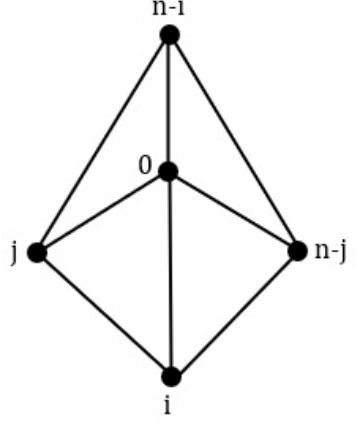
Figure 4. A forbidden subgraph for a line graph in G n